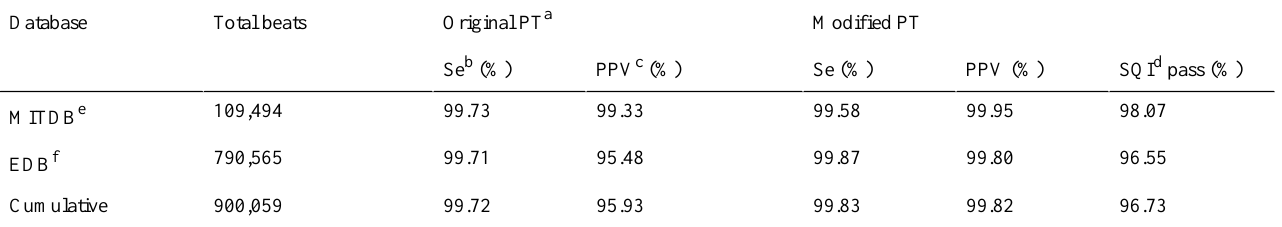
Table 1. QRS classification using the original and modified Pan–Tompkins algorithm on standard